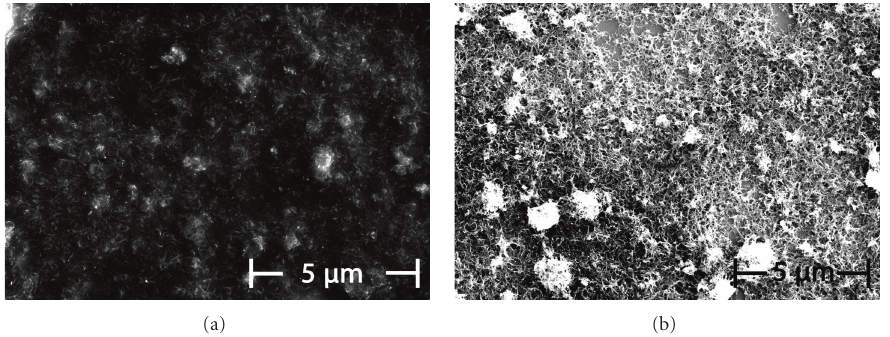
Figure 10: Scanning electron micrographs of the MWCNTs after TGA sample preparation. MWCNTs dispersed at 70% for 72 min (a) and the same specimen heated to 200 ◦ C for 48h (b).